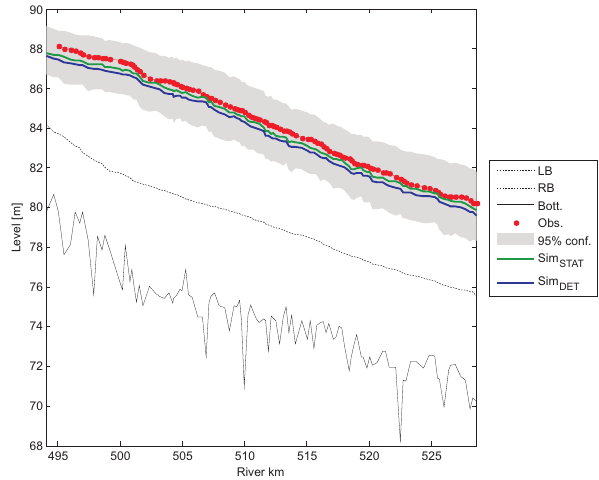
Fig. 4. Validation of the MSS model on the 2010 flood of the War- saw reach. The observations are shown by red dots, median predic- tions obtained from the stochastic approach are shown by a green line, the deterministic solution is shown by the dashed blue line; grey shaded area shows the 0.95 confidence limits, the black con- tinuous line shows the bottom of the river channel and the left and right bank heights are depicted by a dashed line.